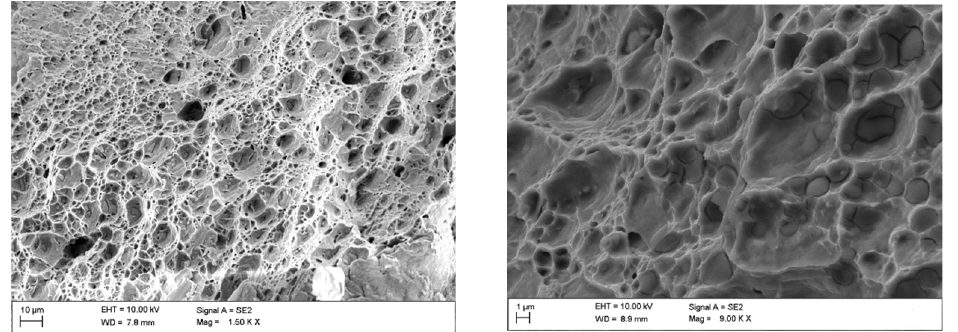
Appl. Sci. 2021 , 11 , x FOR PEER REVIEW Figure 13. SEM morphology of fracture surface: process parameters = 1400 RPM, 65 mm/min, and probe offset = 2.0 mm.